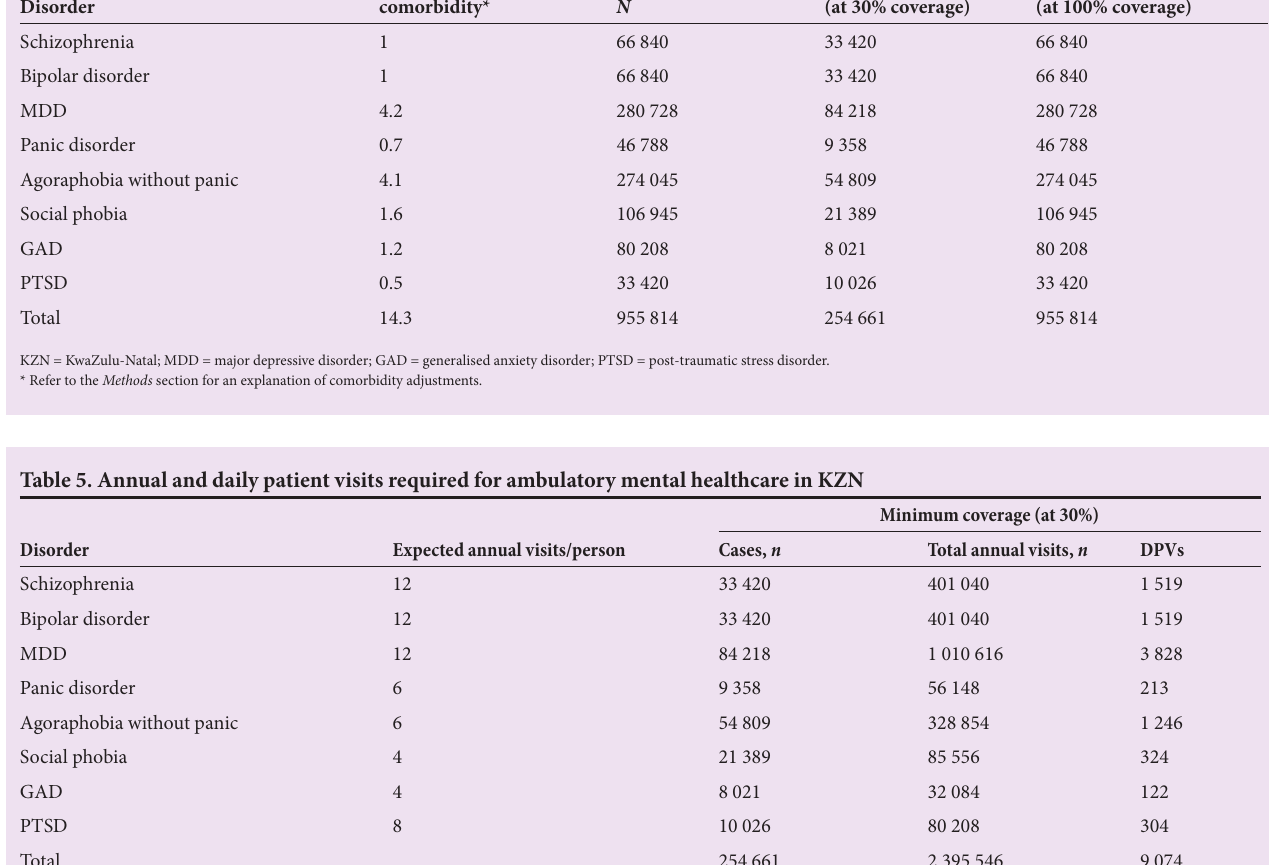
Table 4. Number of individuals requiring ambulatory services at minimum and full coverage in KZN Disorder